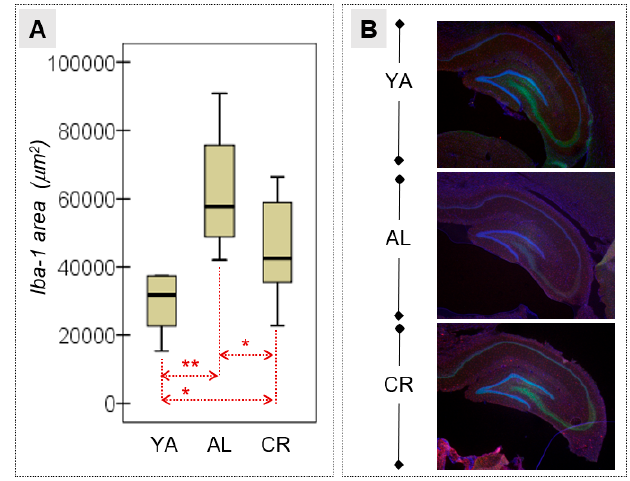
Figure 6. ( A ) Iba-1 expression in the HPC. ( B ) Hippocampal images showing Iba-1 expression in the three groups of animals: DAPI stains the cell nuclei blue, while the microglial cells are immunolabelled for Iba-1 in red. YA, young adults (top); AL, ad libitum (middle); CR, caloric restriction (bottom); * Mild–moderate effect size (| d | > 0.50); ** Large–high effect size (| d | > 0.80).